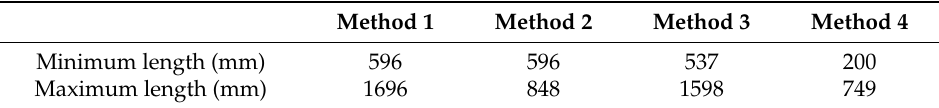
Table 7. Reference lengths per